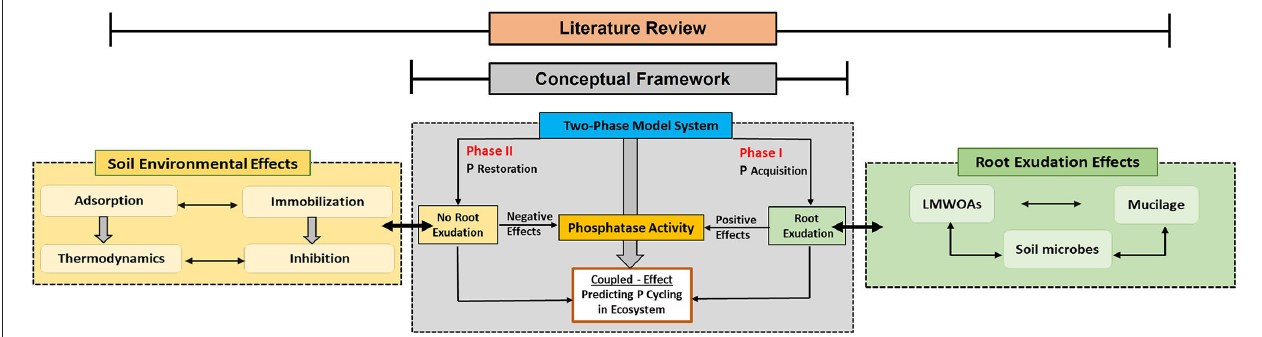
FIGURE 1 | A conceptual two-phase framework that integrates root exudation and soil environment as main drivers of soil phosphatase activity. The dotted lines in each block of main sections indicate their combined effects on phosphatase activity. Based on the conceptual framework block, Phase I shows the soil P o acquisition pathway that is regulated by active root exudation, while Phase II shows soil P o restoration in the absence or with reduced root exudation effects. Both phases are controlled by the P demand of plants with the initiation of P mining processes (green boxes) or by reducing C investment into P mining (yellow boxes).